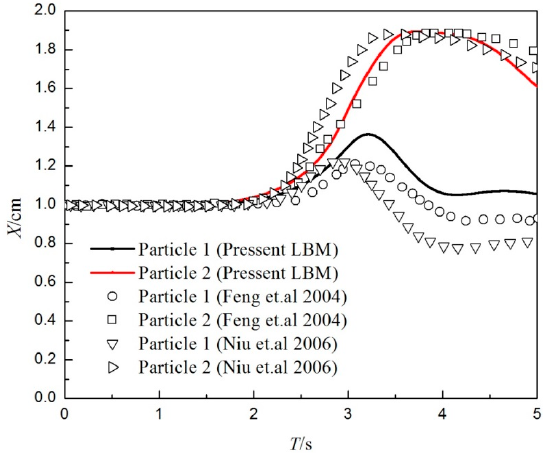
Figure 4. Transverse coordinates of the centers of the two particles.